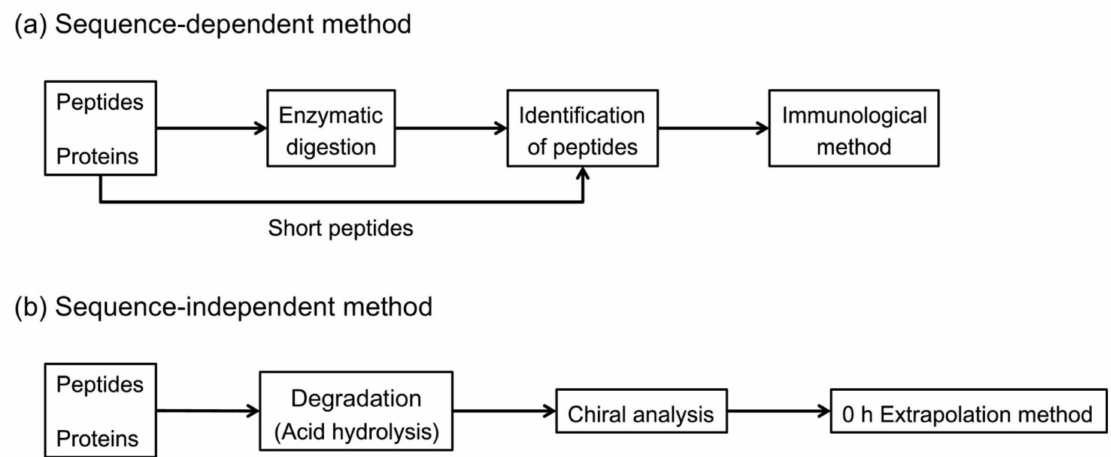
Figure 2. Flow charts for the determination of D -amino acid residues in peptides and proteins using ( a ) sequence-dependent and ( b ) sequence-independent analytical methods. Reproduced with permission from the authors of